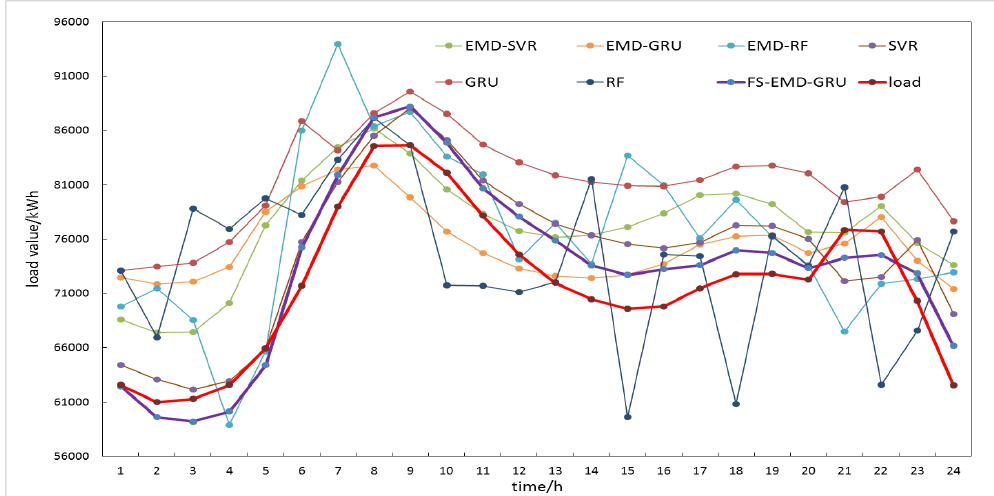
Figure 11. Comparisons of load forecasting results for a certain day in April 2006 of M_3 dataset.